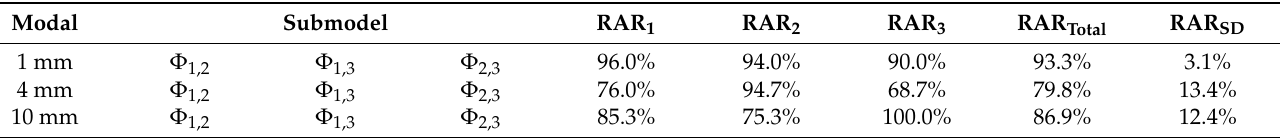
Table 6. Modeling discrimination effect of the joint models for three compensation models’ voting based on